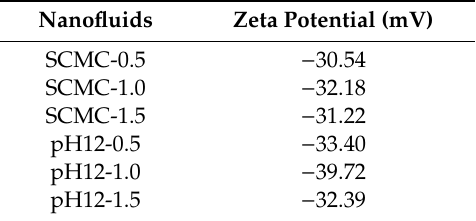
Table 4. Zeta potential of halloysite nanofluids with di ff erent concentrations.